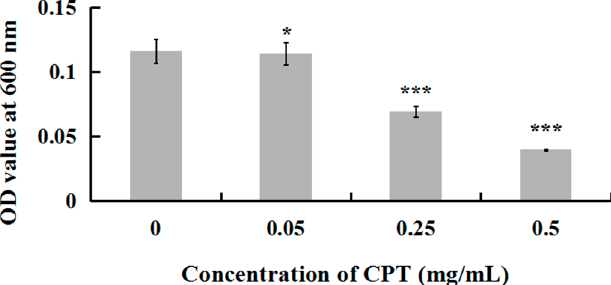
Figure 1. Effect of CPT at different concentrations on the antibacterial activity of Acidovorax avenae subsp. avenae strain RS-2. *: p < 0.05; ***: p < 0.001. Error bars represent the standard error of the mean ( n = 6). Data are from a representative experiment repeated twice with similar results.